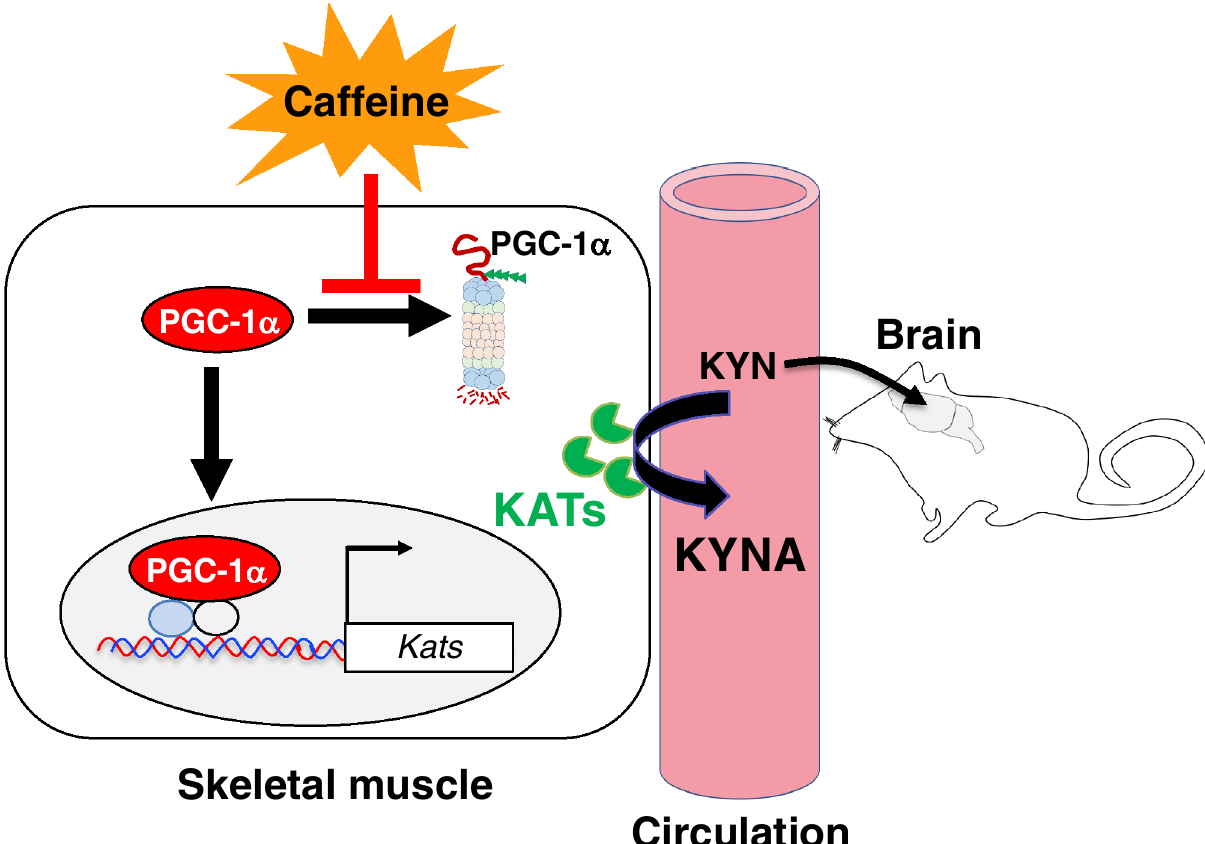
Figure 7. Proposed model for the protective role of caffeine against CMS-induced depression. CMS-exposed mice showed depressive-like behaviour with an increase in plasma levels of kynurenine (KYN). Caffeine supplementation protected against depressive behaviours in CMS-exposed mice, accompanied by restoration of plasma concentrations of BBB-permeable, pro-neurotoxic KYN, and BBB-impermeable KYNA. In addition, caffeine administration activated kynurenine aminotransferase (KAT) which consumed KYN by converting it to KYNA in the skeletal muscles of the mice. Indeed, caffeine stimulated myotubes to sustain PGC-1α, a transcription factor for KAT, by inhibiting their proteasomal degradation. These events converge on KAT- mediated consumption of KYN, eventually leading to a reduction in plasma and brain levels of